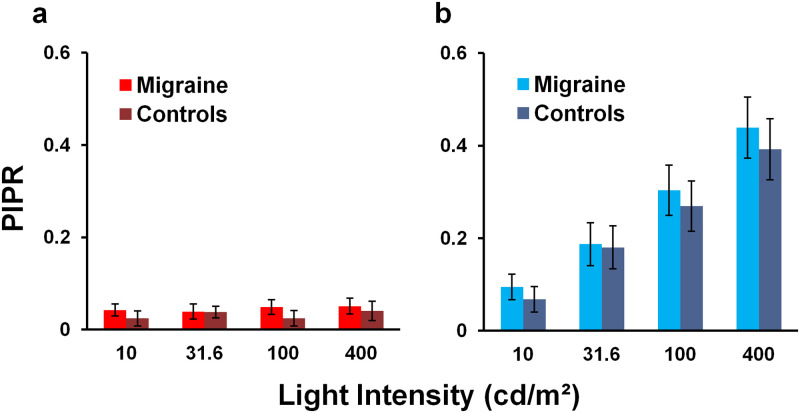
Mean PIPR responses of the left eye.PIPR was measured in response to four light intensity steps, each of 400 ms duration, using (a) red and (b) blue light stimulation. Error bars represent 95% confidence intervals. No statistically significant differences were found between migraine and control groups at each stimulus intensity following red or blue light stimulation.